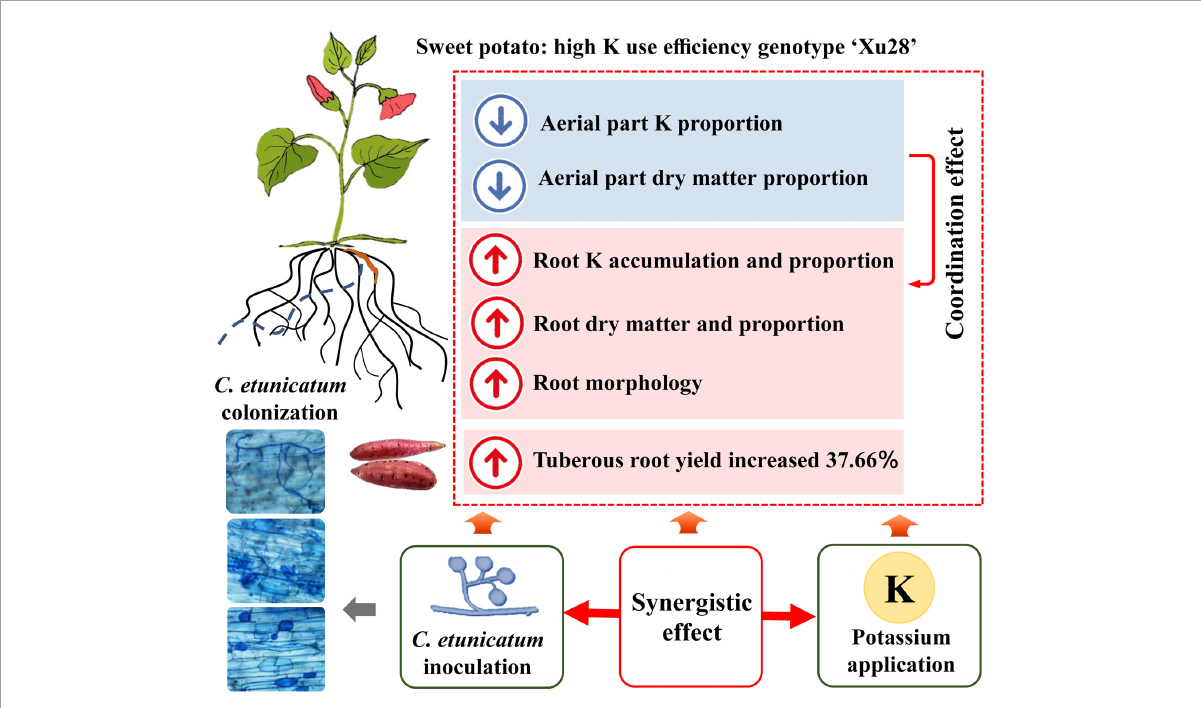
FIGURE9 Conceptual diagram depicting the synergistic effect of K and arbuscular mycorrhizal fungi (AMF) on root development and K acquisition of high K use efficiency genotype